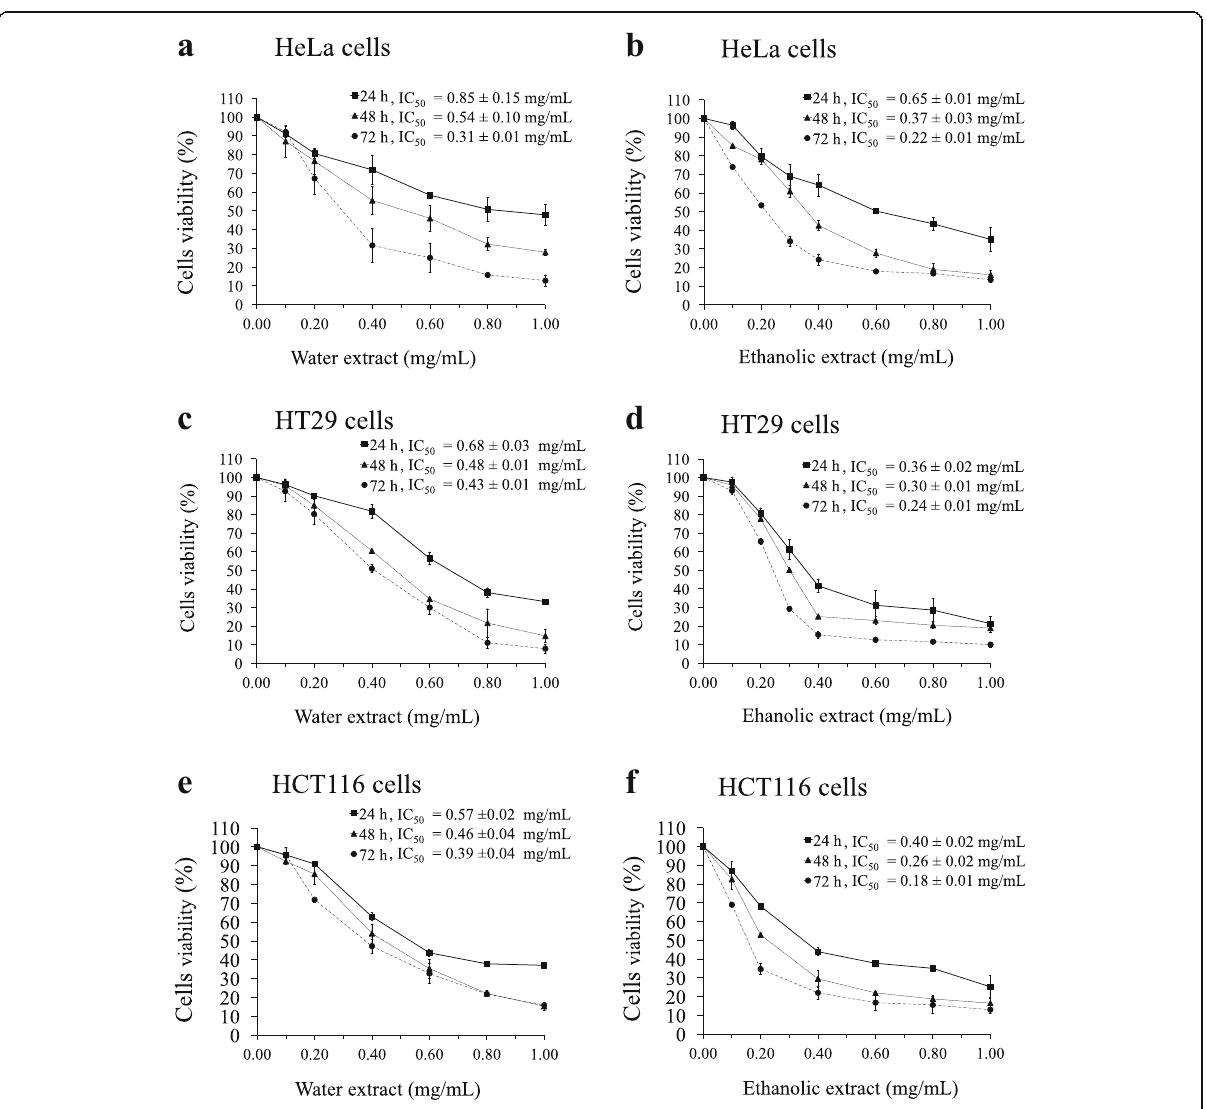
Fig. 1 Effect of water and ethanolic extracts prepared from the powdered formula of H. cordata fermented broth and P. emblica fruit on proliferation of HeLa ( a , b ), HT29 ( c , d ) and HCT116 ( e , f ) cells, treated for 24, 48 and 72 h. The cell viability was calculated by comparison with the control, 0.5% DMSO treated. The results were shown as mean ± S.D. ( n = 6). The average of half maximal inhibitory concentration (IC 50 ) values calculated from 3 independent experiments was presented along with a line